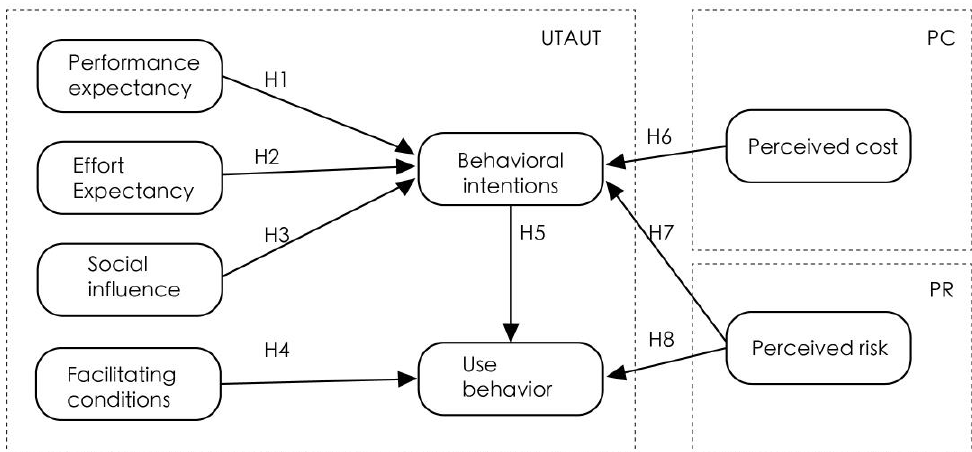
Figure 3. Research model.